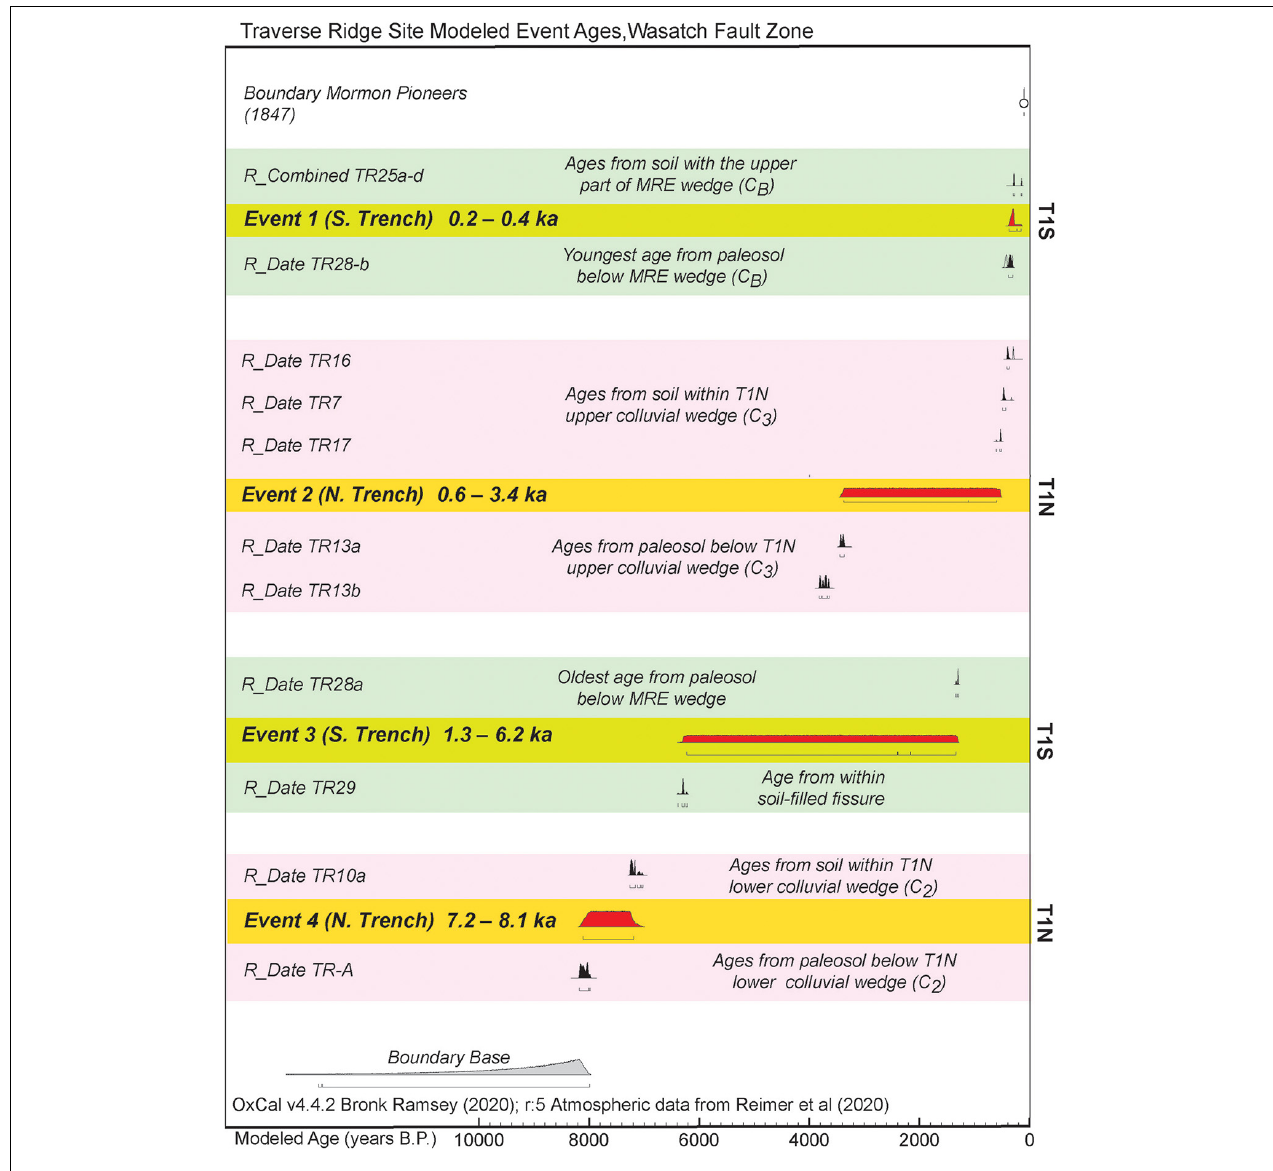
FIGURE 7 | OxCal model (e.g., Lienkaemper and Bronk Ramsey, 2009; Bronk Ramsey, 2017) for TR site event ages are constrained by geochronology samples from bounding stratigraphic units within trench T1S (green shading) and trench T1N (pink shading). Geochronology ages ( Tables 1 , 2 ) were modeled either as single ages as a part of an overall sequence of events (i.e., TR-A, TR10a, TR29, TR28a, and TR28b), as a sequence within a stratigraphic unit (i.e., TR-13b, TR13a, TR17, TR7, and TR16), or as a combined age group (TR25a, TR25b, TR25c, and TR25d). The upper boundary of 1847, when Mormon Pioneers entered the region–and no strong earthquakes were felt–is used to help constrain the combined age of TR25 and therefore also helps constrain the age of the most recent earthquake (Event 1). Event ages, rounded to the nearest 0.1 ka, are presented here. Full 2 σ modeled event ages are presented in Table 3 . Evidence for Event 2 and Event 3 is from separate trenches and has overlapping age probability distribution functions. Therefore, we cannot be certain if these are the same event or separate